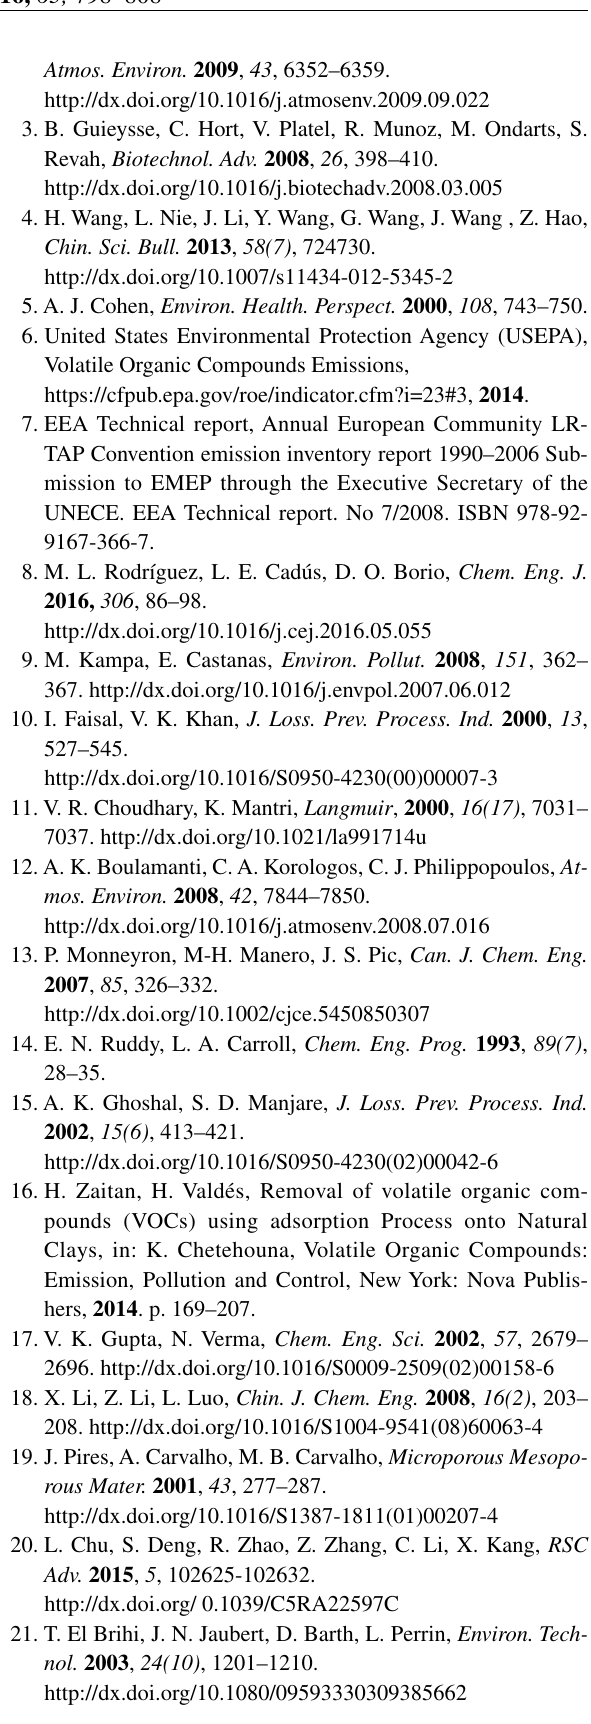
Table 4, the maximum adsorption capacity of Fau Y zeoli- te at 300 K, is almost 2 to 4 times higher than the values of FS natural clay. This means that FS natural clay in order to have an equivalent adsorption capacity to Fau Y zeolite, it is necessary to use a mass of FS natural clay 2–4.5 times higher than that required mass of Fau Y